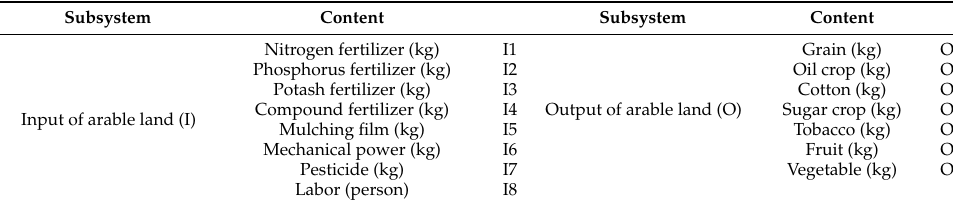
Table 1. Indicators of the subsystem of input–output on arable land. Subsystem Content